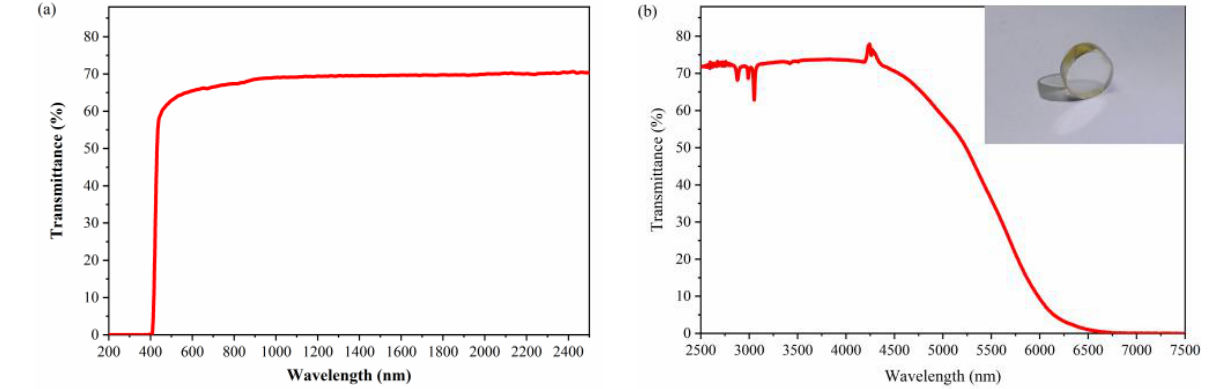
Figure 7. Transmission spectra of crystals in the ( a ) visible band and ( b ) infrared band.